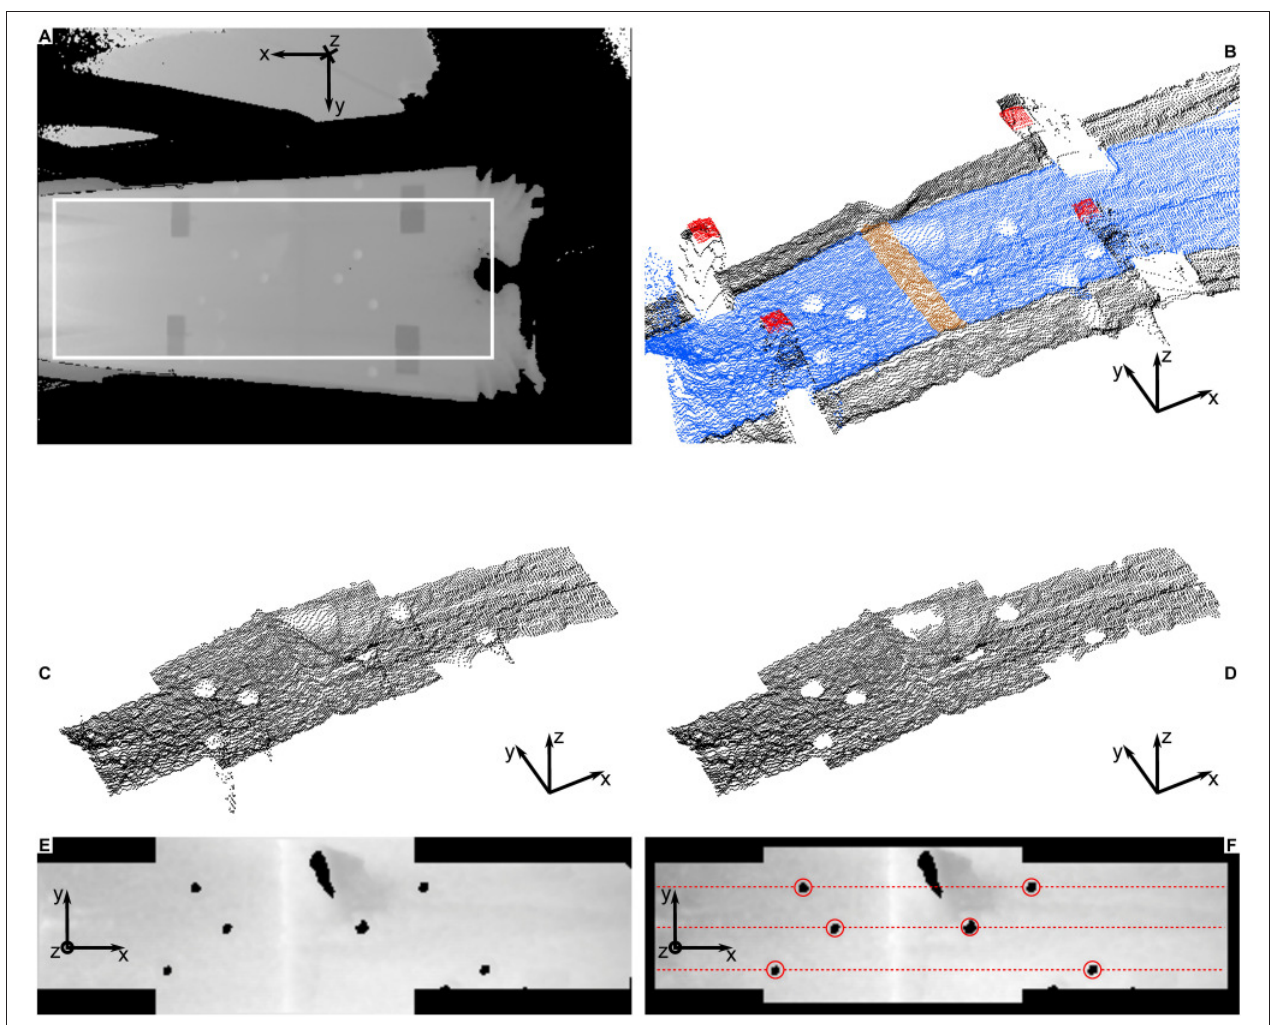
FIGURE 3 | Processing steps of the Kinect data. The coordinate system in each sub-figure shows the same real-life directions: x is the streamwise direction, y is the cross-stream direction and z is the vertical. (A) Raw Kinect depth image. The four darker rectangles are the targets, the lighter circles are SMP holes. The black circular shape on the right is the reflection blind spot. The other black areas are too close to the sensor to be resolved. (B) Point cloud of the raw depth image inside of the white rectangle in (A) . The targets are red, the snow surface is blue and an almost buried artificial obstacle is colored brown. (C) Point cloud cropped to contain only the snow surface and the obstacle. The four corners are cut away to remove the targets. (D) Filtered point cloud. Isolated points are removed. The SMP holes are now more clearly visible. There is also a measurement shadow just downstream of the obstacle. (E) Processed depth image. The SMP holes and the measurement shadow appear as black areas, as do the cut off corners. The obstacle is visible as a light, vertical line. (F) Processed and corrected depth image. The edges are cut away during the correction. The effect of the correction is most visible on the left. The red circles indicate the manually determined SMP positions. The dashed, red lines show the three lines on which all SMPs are acquired and where the Kinect profiles are calculated.